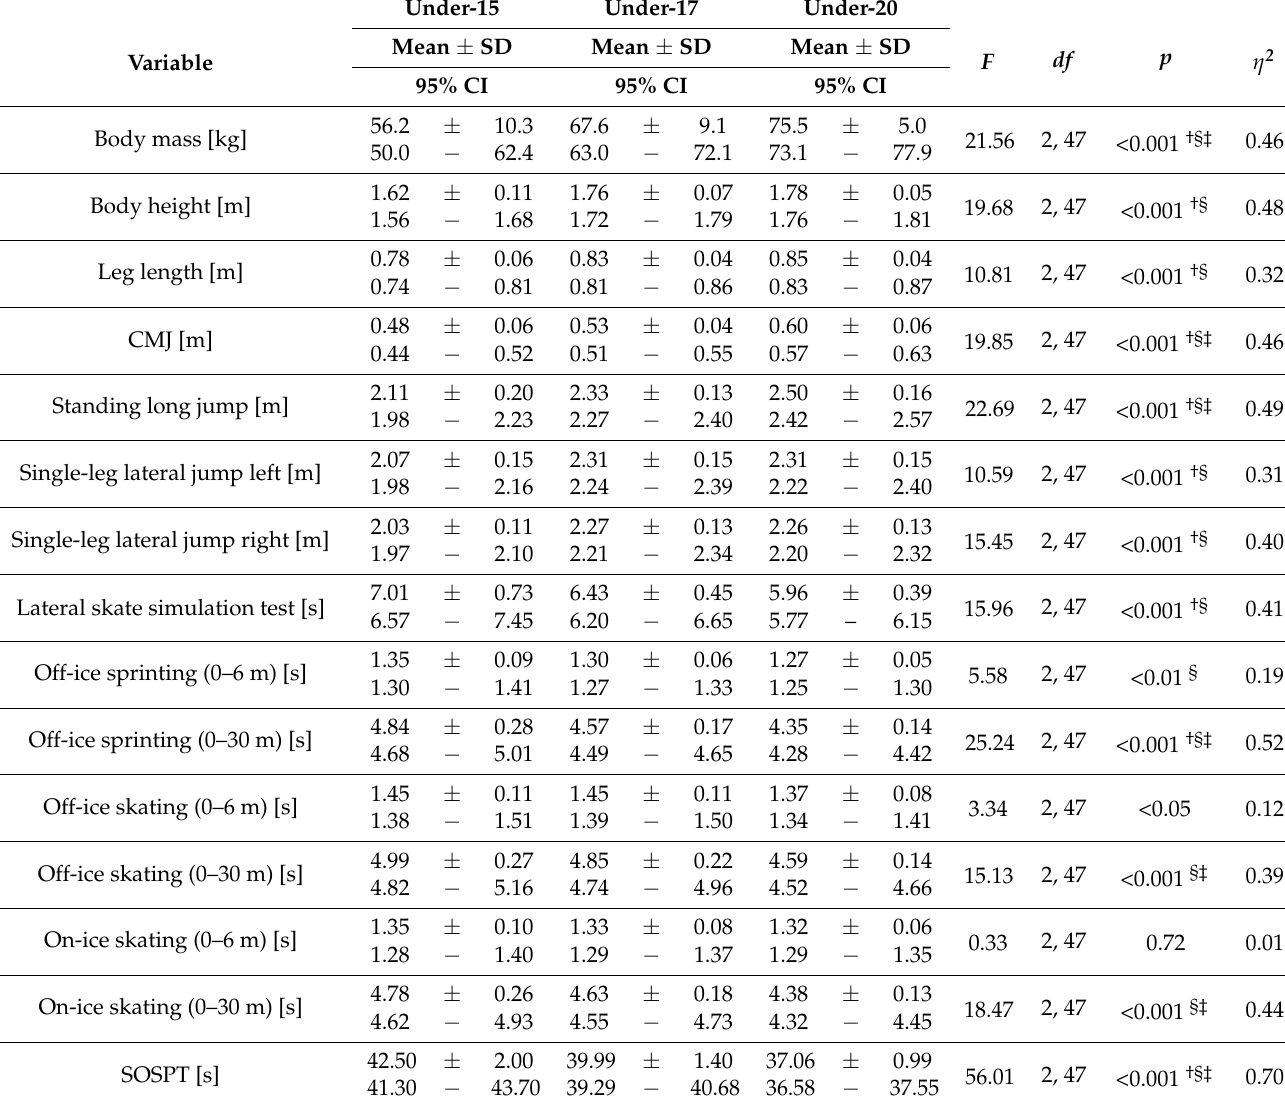
Table 1. Mean ± standard deviations (SD), 95% confidence intervals (CI), F -statistics and effect sizes ( η 2 ) for the main effects of measurements. Under-15 Under-17